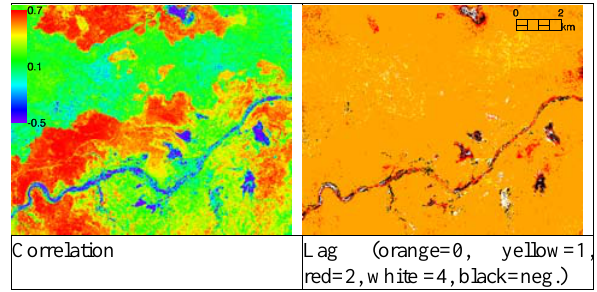
Figure 4: Lagged correlation between rainfall and NDVI.